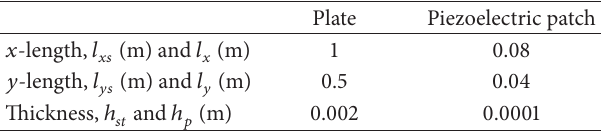
Table 2: Geometrical properties of the plate and the piezoelectric sensors and